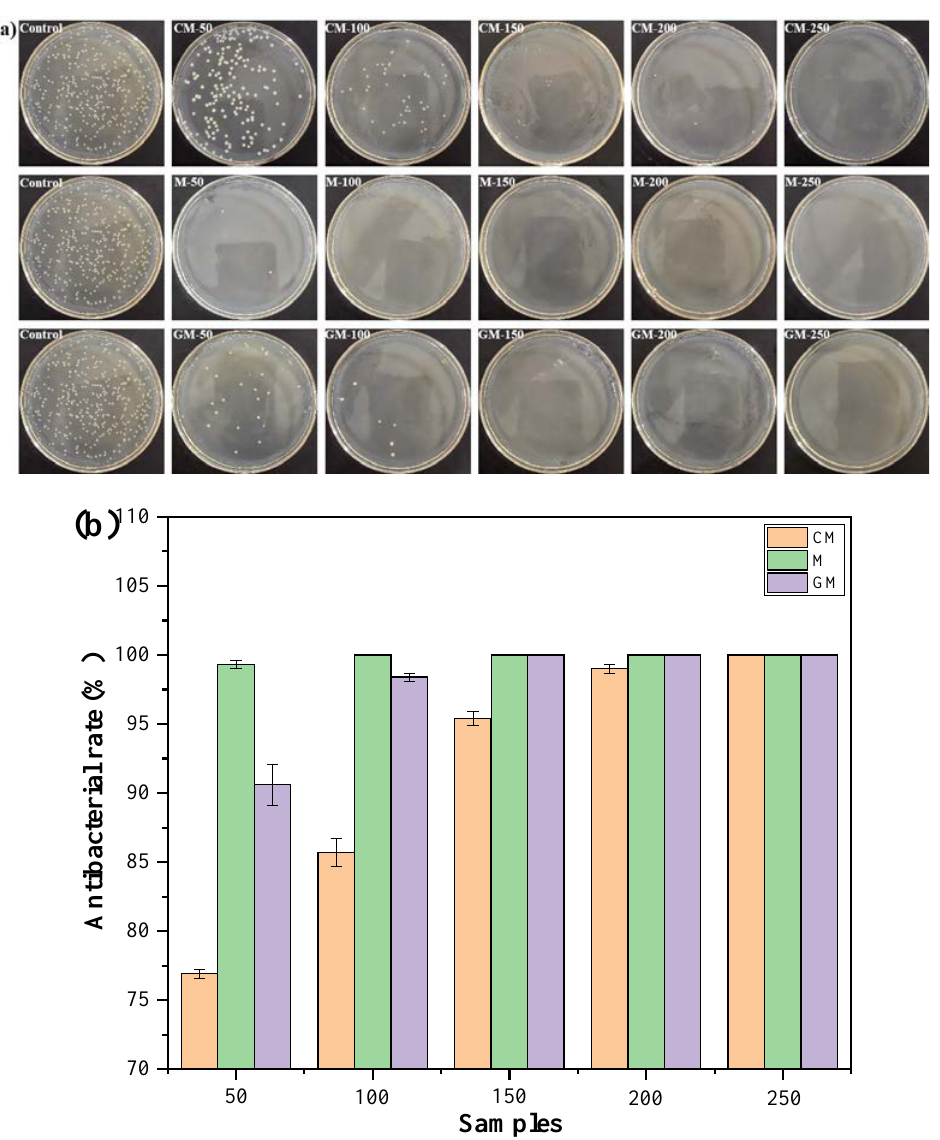
Figure 6. The ( a ) E. coli colony on agar plates and ( b ) antibacterial rate of the fabrics. Table 6. The E. coli colony numbers of the fabrics on the agar plates.